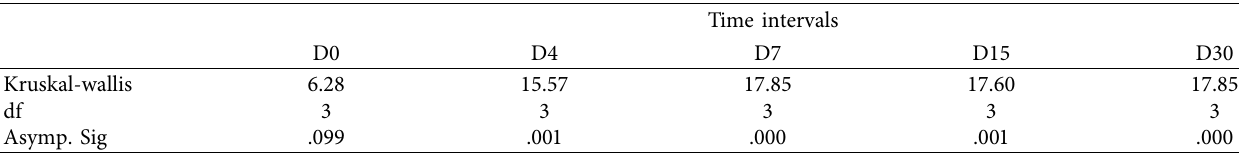
Table 4: Results from comparisons of CFU/mL of S. mutans between treatment groups with each other at each of the intervals, based on the Kruskal-Wallis test. Time intervals D0 D4 D7 D15 D30 Kruskal-wallis 6.28 15.57 17.85 17.60 17.85 df 3 3 3 3 3 Asymp. Sig .099 .001 .000 .001